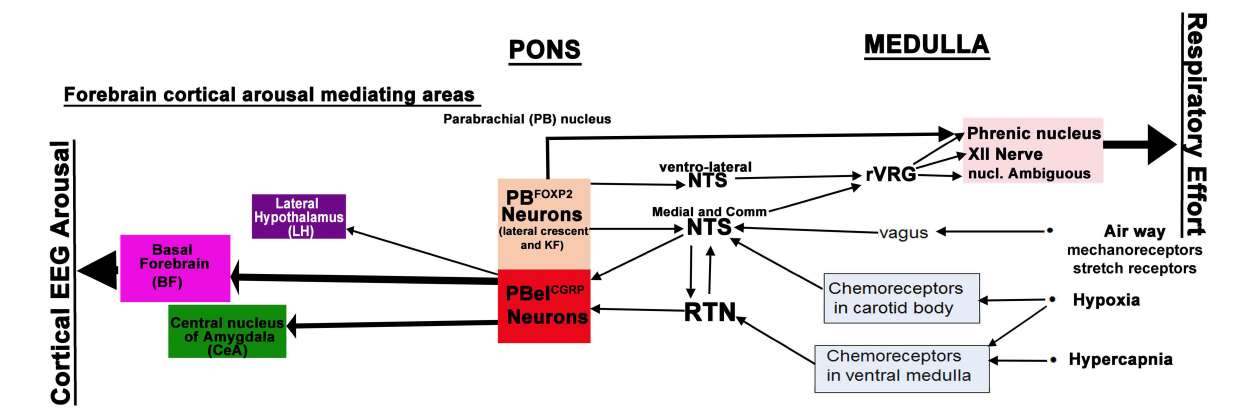
FIGURE 5 | Neural circuitry regulating cortical arousals and respiratory efforts to hypercapnia: PBel CGRP neurons receive CO2, O2, and airway mechanoreceptor inputs, as well as inputs via medullary nuclei, NTS (nucleus of solitary tract) and RTN (Retrotrapezoid nucleus). The PBel CGRP neurons in turn project extensively to the lateral hypothalamus (LH), basal forebrain (BF), and central nucleus of amygdala (CeA). Based on our findings, PBel CGRP neurons mainly cause cortical arousal by projections to the BF, which has potent waking effects, followed by CeA and LH. PBel CGRP neurons did not contribute to respiratory component of apnea, as its inhibition did not diminish respiratory drive to CO2. The glutamatergic FoxP2 neurons (PB FoxP2 ) in the lateral crescent (PBlc) and Kolliker Fuse (KF) have descending projections to the hypoglossal nucleus (tongue), and to the retroambiguus (larynx) and phrenic motor nucleus (Diaphragm); they also project extensively to the ventro-lateral and commissural (Comm) subdivisions of NTS. These projections of the PB FoxP2 neurons may influence the respiratory efforts during apneas, either by direct projections to the motor neurons in medulla and spinal cord or by indirect projections to the premotor neurons in the ventro-lateral medulla, also known as the rostral Ventral Respiratory Group